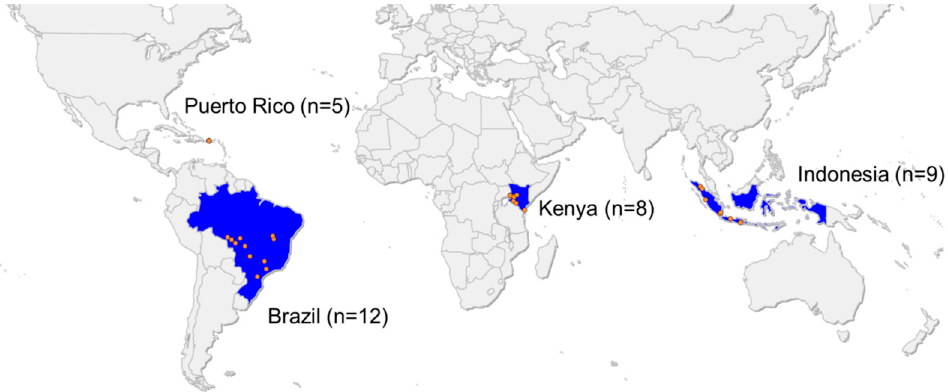
Figure 1. Map showing the origin of 34 fall armyworm populations collected in Brazil, Puerto Rico, Kenya and Indonesia (more details about collection sites in Table S1). All samples were used for the genotyping of target-site mutations. The schematic map was created using EasyMap software (Lutum + Tappert DVBeratung GmbH, Bonn, Germany).